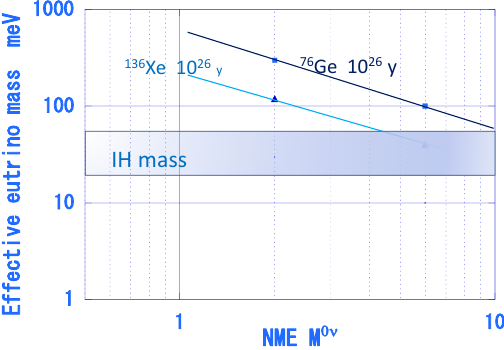
Figure 5. Effective neutrino mass m ef f and NME M 0 ν . IH: the IH effective mass. Two lines show upper limits in the case of the halflife limits of 10 26 y for 76 Ge and 136